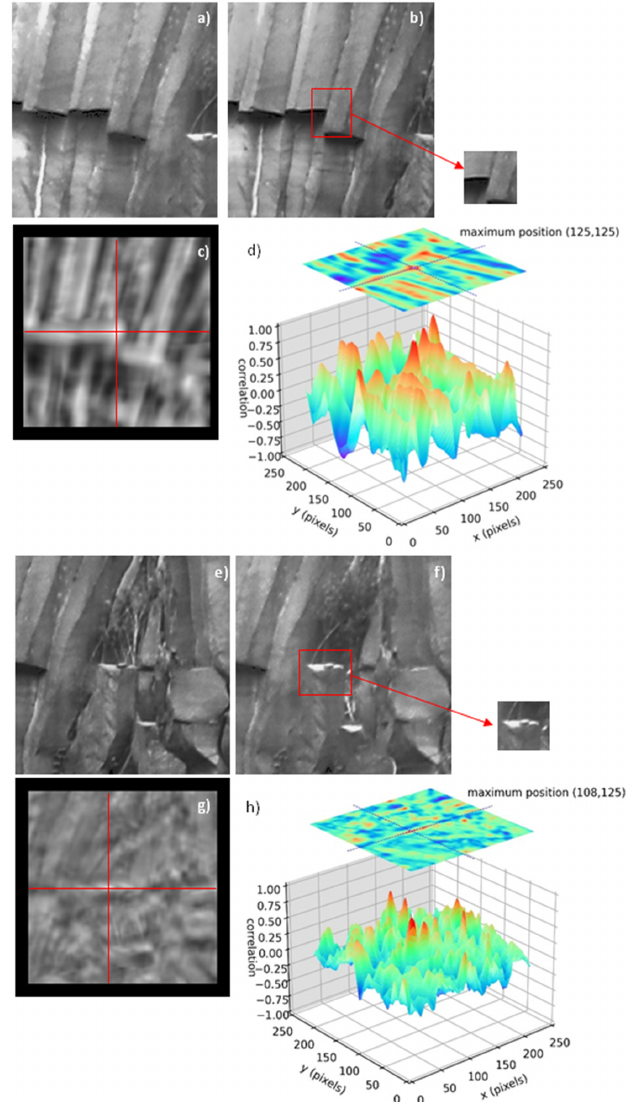
Figure 5. Examples of correlation between images. Original images ( a ) and ( e ) are the ones that correlate with the patterns ( b ) and ( f ). On top is an example of high correlation and column immobility. Image ( c ) shows the 2D visualization of matrix correlation, represented in 3D in image ( d ) and ( h ). The cross of the lines shows the position of the maximum value centered in the matrix image. On the bottom is an example of high correlation and column displacement. Image ( g ) shows the 2D visualization of matrix correlation, which is represented in 3D in image ( g ). The cross of the lines on it shows the position of the maximum value that is not centered in the matrix image due to the movement.